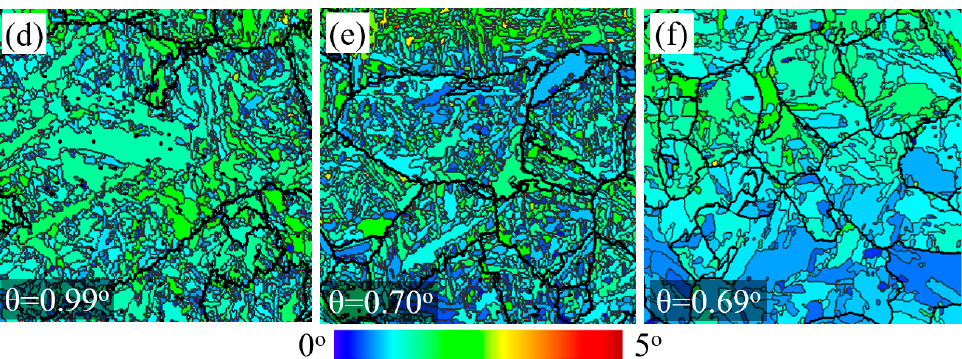
Figure 3. CPP packets in three specimens at various cooling rates: ( a ) water-quenching; ( b ) 5 °C/s; ( c ) 0.05 °C/s. The colors indicate four different CPP packets. Kernel average misorientation maps (one average value per grain): ( d ) water-quenching; ( e ) 5 °C/s; ( f ) 0.05 °C/s. 𝜃 is the local misorientation angle averaged on the grains of the map.